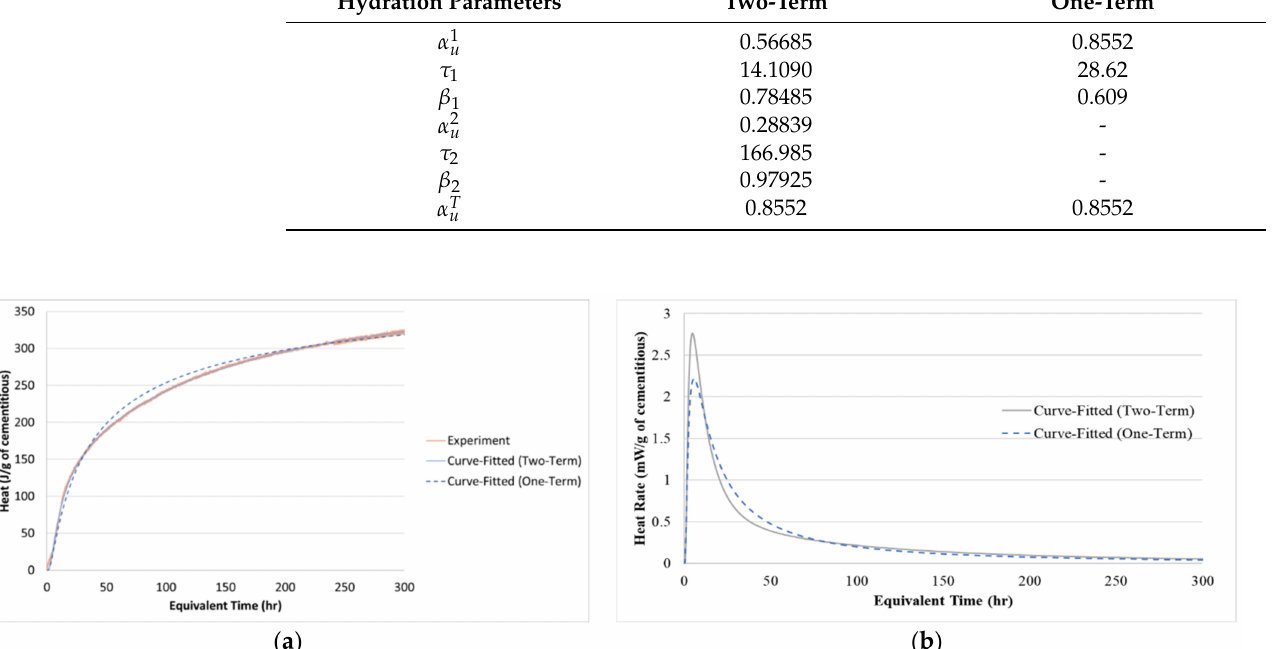
Figure 4. Adiabatic measurement of heat: ( a ) Accumulated heat and ( b ) Heat rate